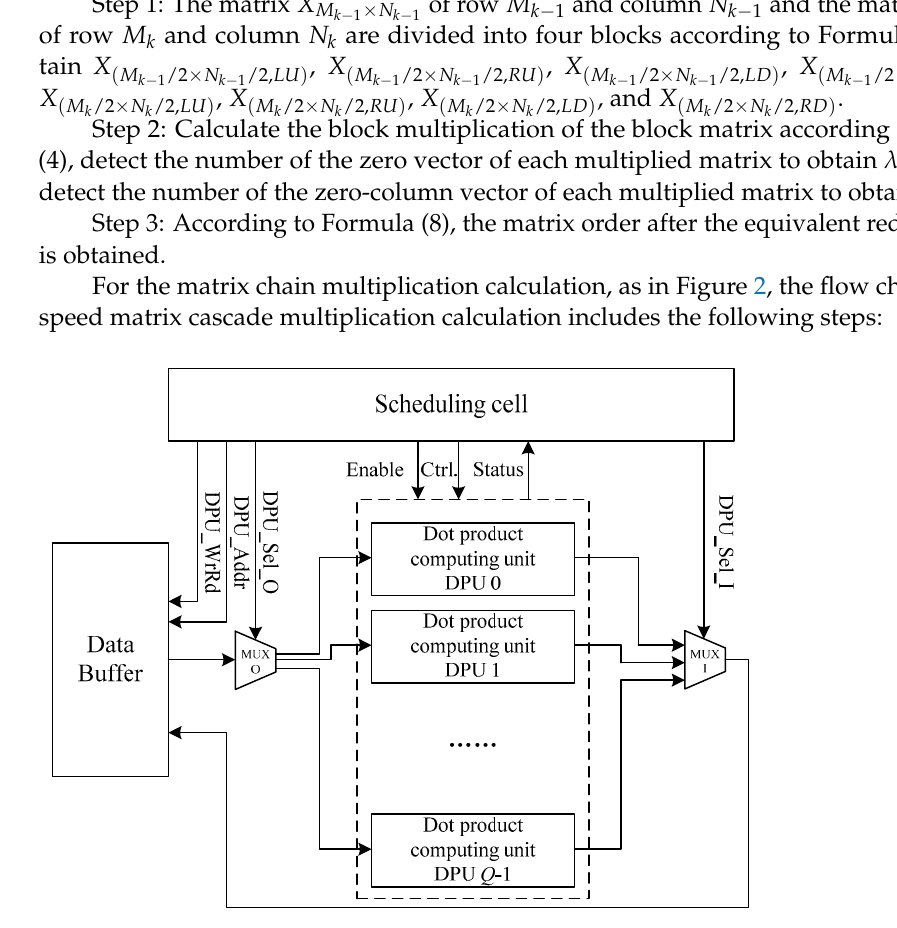
Figure 2. Hardware design block diagram of high-speed matrix chain multiplication parallel dot product calculation.